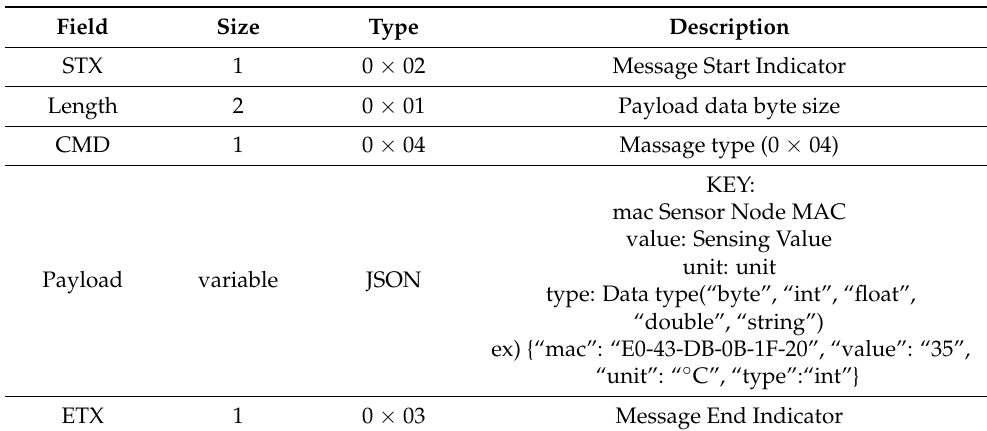
Table 13. Communication protocol for transmitting temperature measurements.